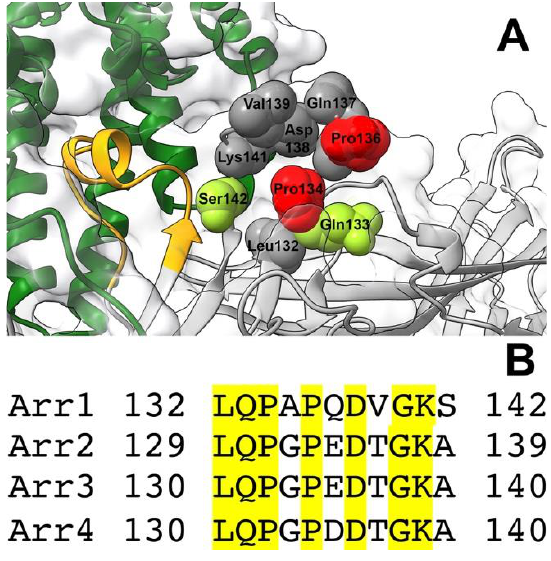
Figure 7. Middle loop in arrestin family members. ( A ) The structure of the middle loop in rhodopsin-bound arrestin-1 (complex A, PDB ID: 5w0p [7]). Arrestin (gray) and rhodopsin (dark green) are shown as ribbons with molecular surfaces indicated. The finger loop of arrestin-1 is shown in orange (arrow indicates N-to-C direction). Middle loop residues are shown as CPK models; two prolines in WT arrestin-1 that appear to suppress binding are shown in red; two residues important for binding (as the mutations of these residues reduce the binding on all backgrounds) are shown in light green; all other residues are shown in gray. Side chains are labeled with bovine arrestin-1 residue numbers (mouse arrestin-1 used in the structure has an identical middle loop, with the residue numbers N + 1, as compared to bovine protein). The image was created in DS ViewerPro 6.0 (Dassault Syst è mes, San Diego, CA, USA). ( B ) The alignment of the sequences of middle loops of bovine arrestin-1, -2, -3, and -4. The numbers of the first and the last residue are indicated. Identical residues are shaded